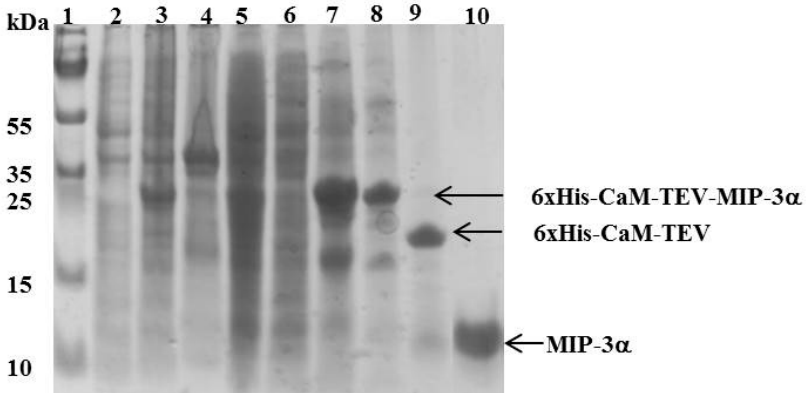
Figure 3. SDS-PAGE showing the expression and purification of MIP-3 α . Lane 1 shows the molecular mass marker. Lanes 2 and 3 represent the E. coli cell lysate before and after IPTG induction, respectively. Lanes 4 and 5 represent the pellet and the supernatant of the cell lysate, respectively after a high speed centrifugation (18,000 rpm for 45 min at 6 °C). Lane 6 represents the unbound protein eluted from the Ni 2+ -column. Lane 7 represents the peak fraction eluted from the Ni 2+ -column with 400 mM imidazole. In lane 8, the elution fraction was dialyzed against 20 mM Tris HCl pH 7.8 and 100 mM NaCl. Lane 9 shows the dialyzed sample digested with TEV protease. Lane 10 shows the final MIP-3 α purified by HPLC.